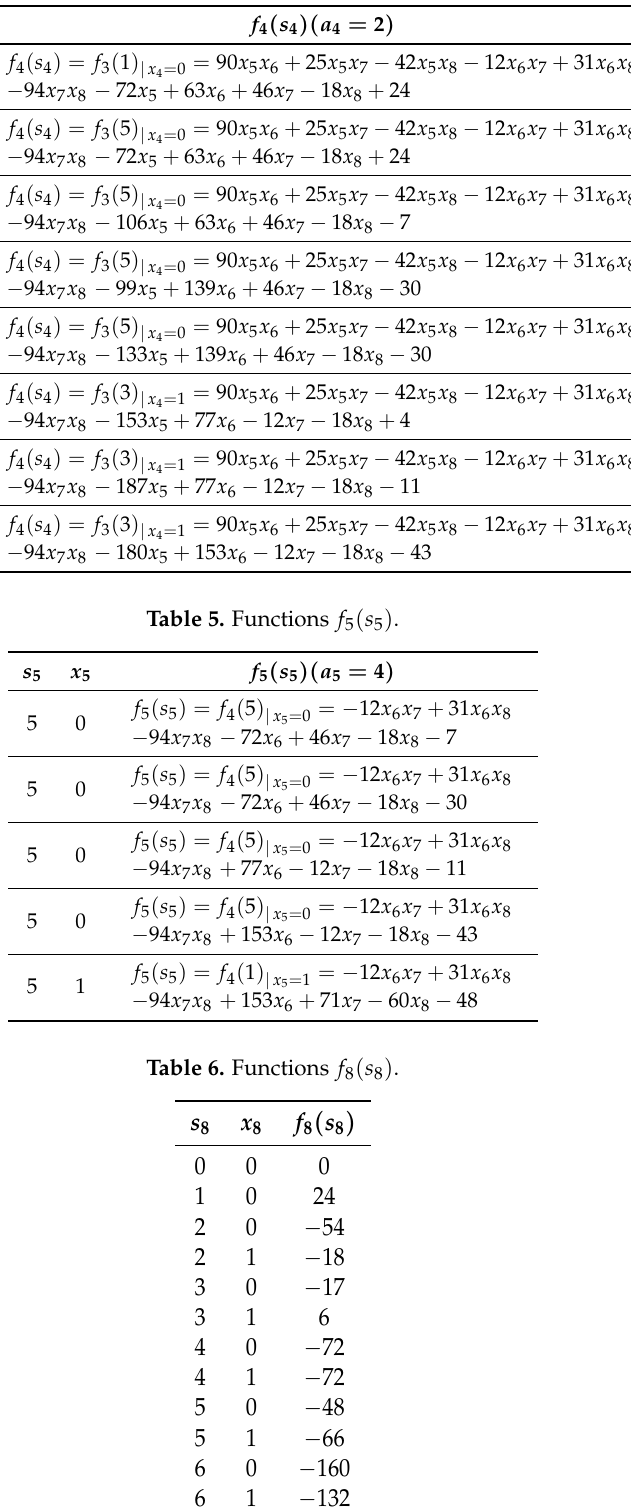
Table 4. Functions f 4 ( s 4 ) .